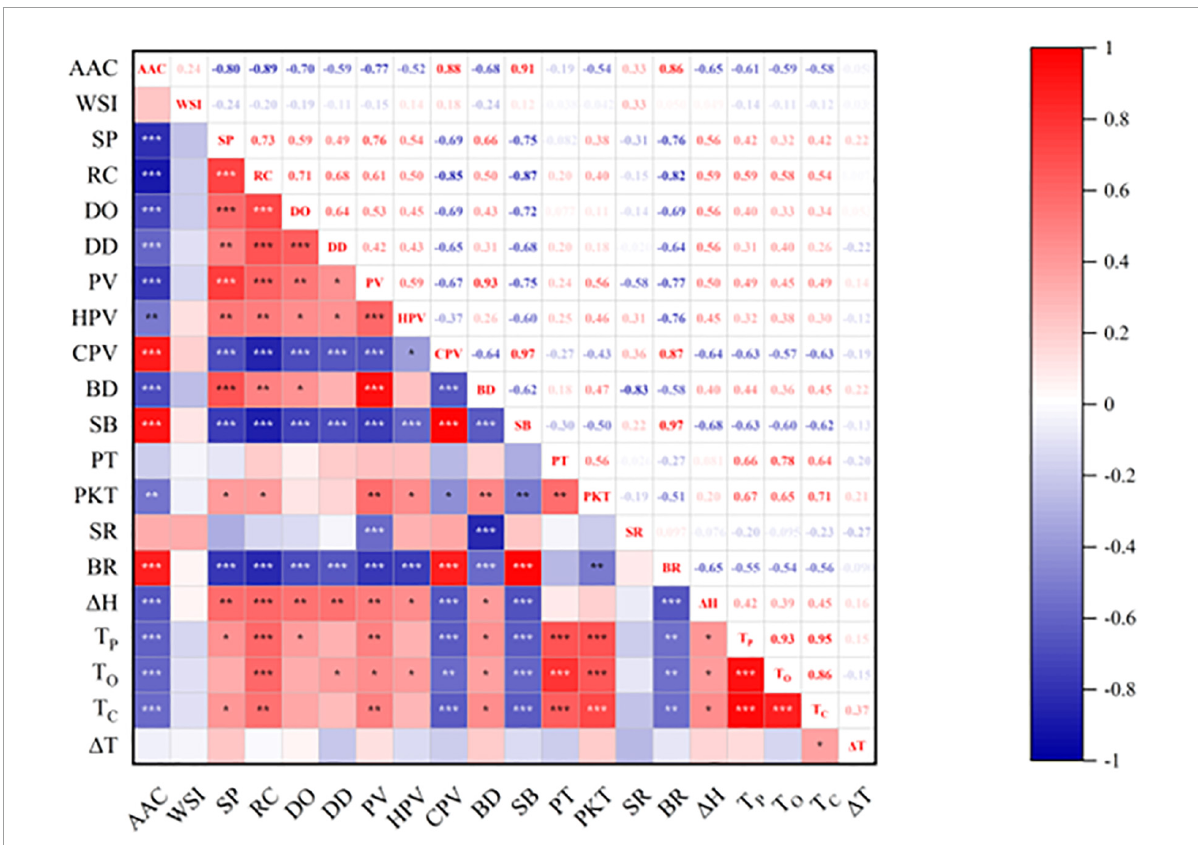
FIGURE6 Pearson correlation coefficients among various physicochemical properties of sorghum starch. * p ≤ 0.05, ** p ≤ 0.01, *** p ≤